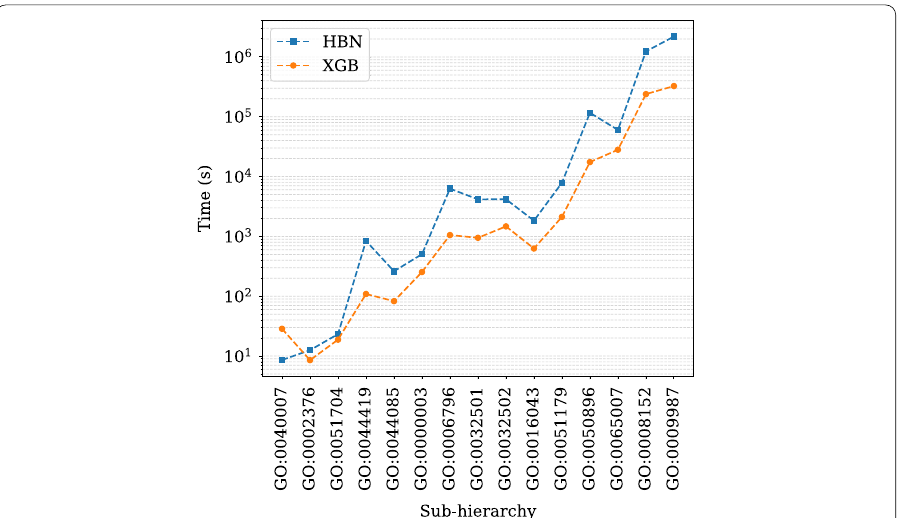
Fig. 7 Execution time of the hierarchical multi-label classification approach with XGBoost (XGB) classifier and the HBN model for the prediction of the 15 sub-hierarchies. The execution time is measured in seconds and plotted in logarithmic